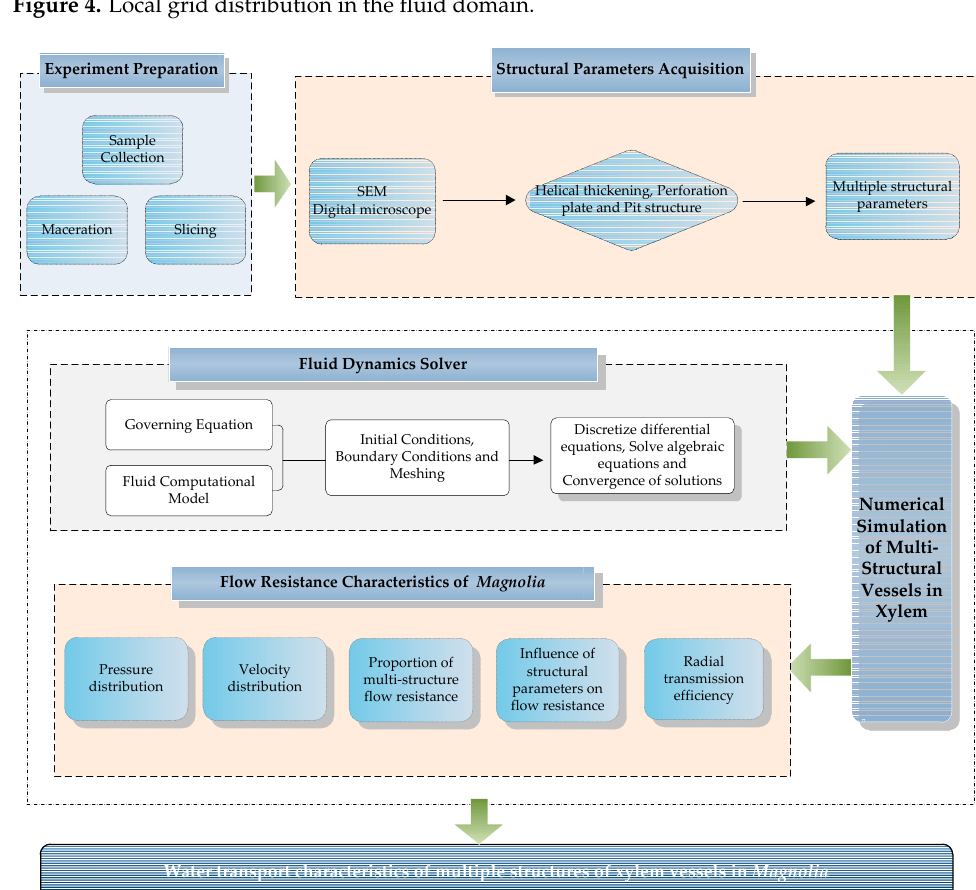
Figure 5. Flow chart of the flow resistance characteristics of xylem